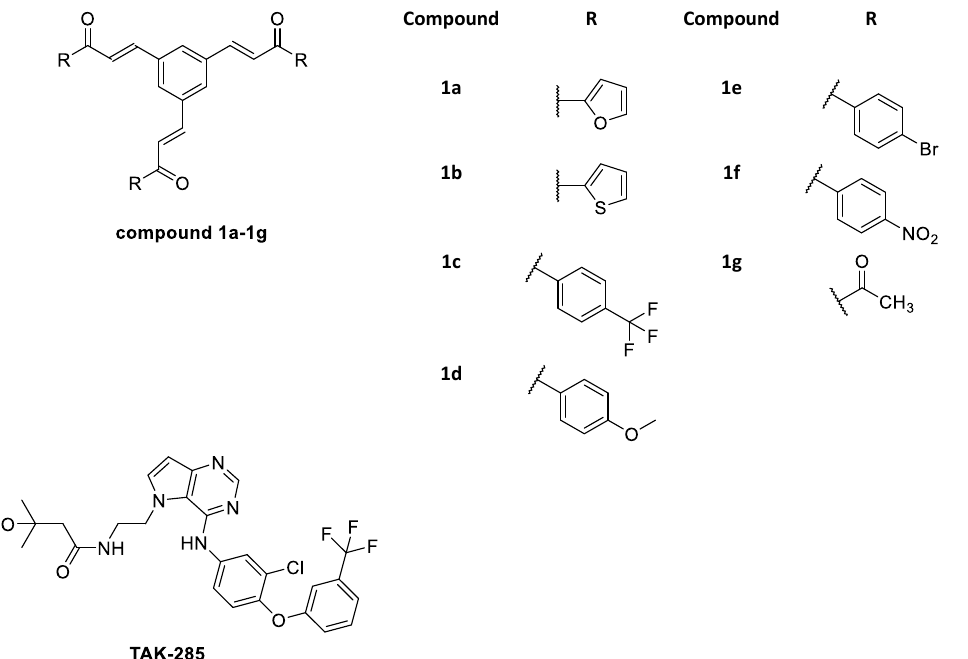
Figure 1. 2D Structures of TAK-285 and novel chalcone derivatives 1a – 1g .